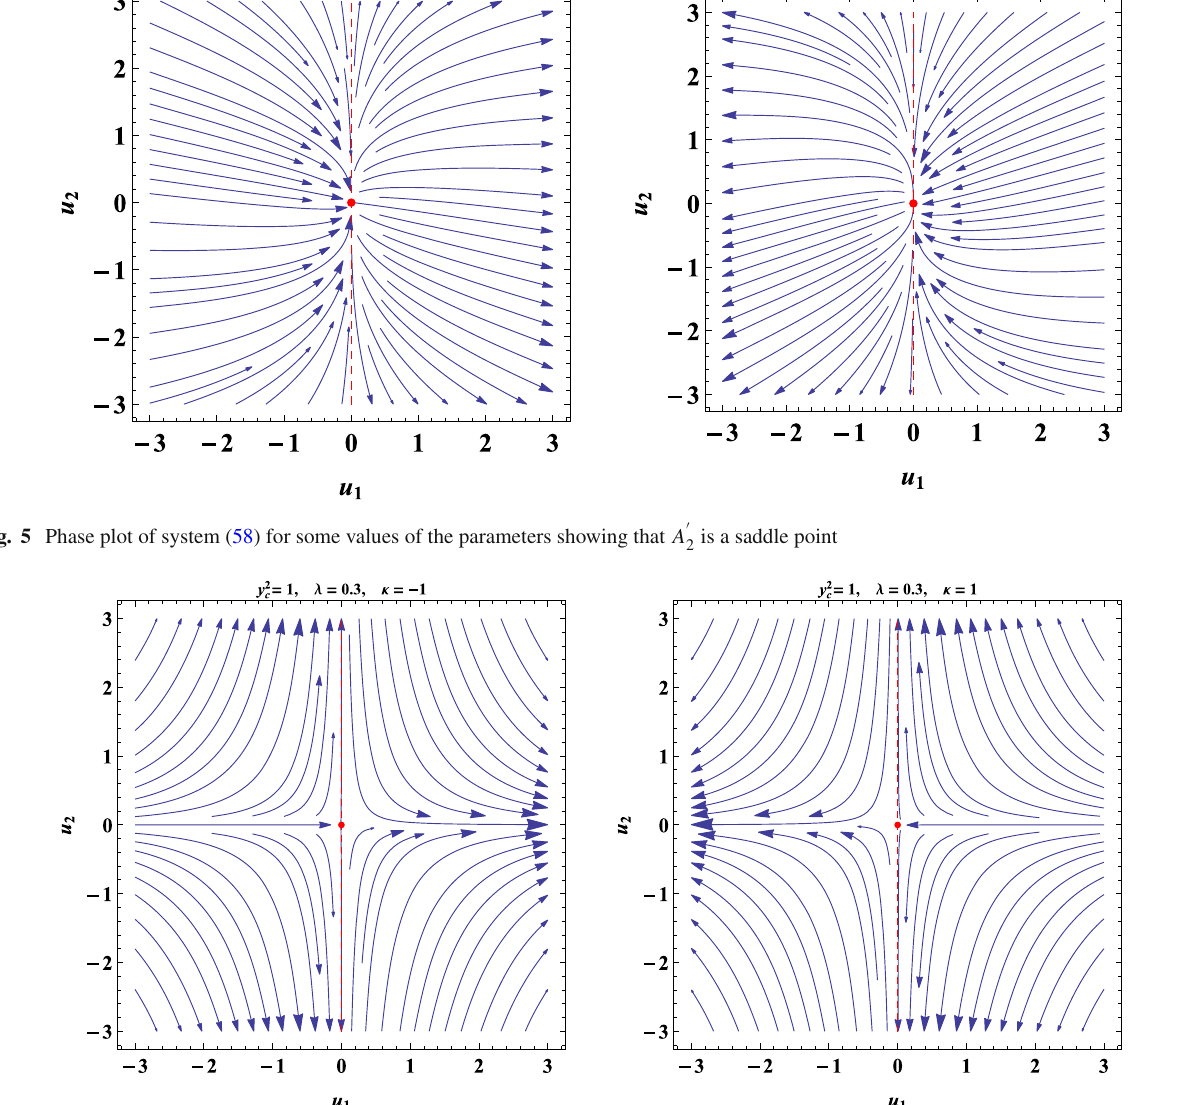
Fig. 6 Phase plot of system (64) for some values of the parameters showing that A (cid:4)